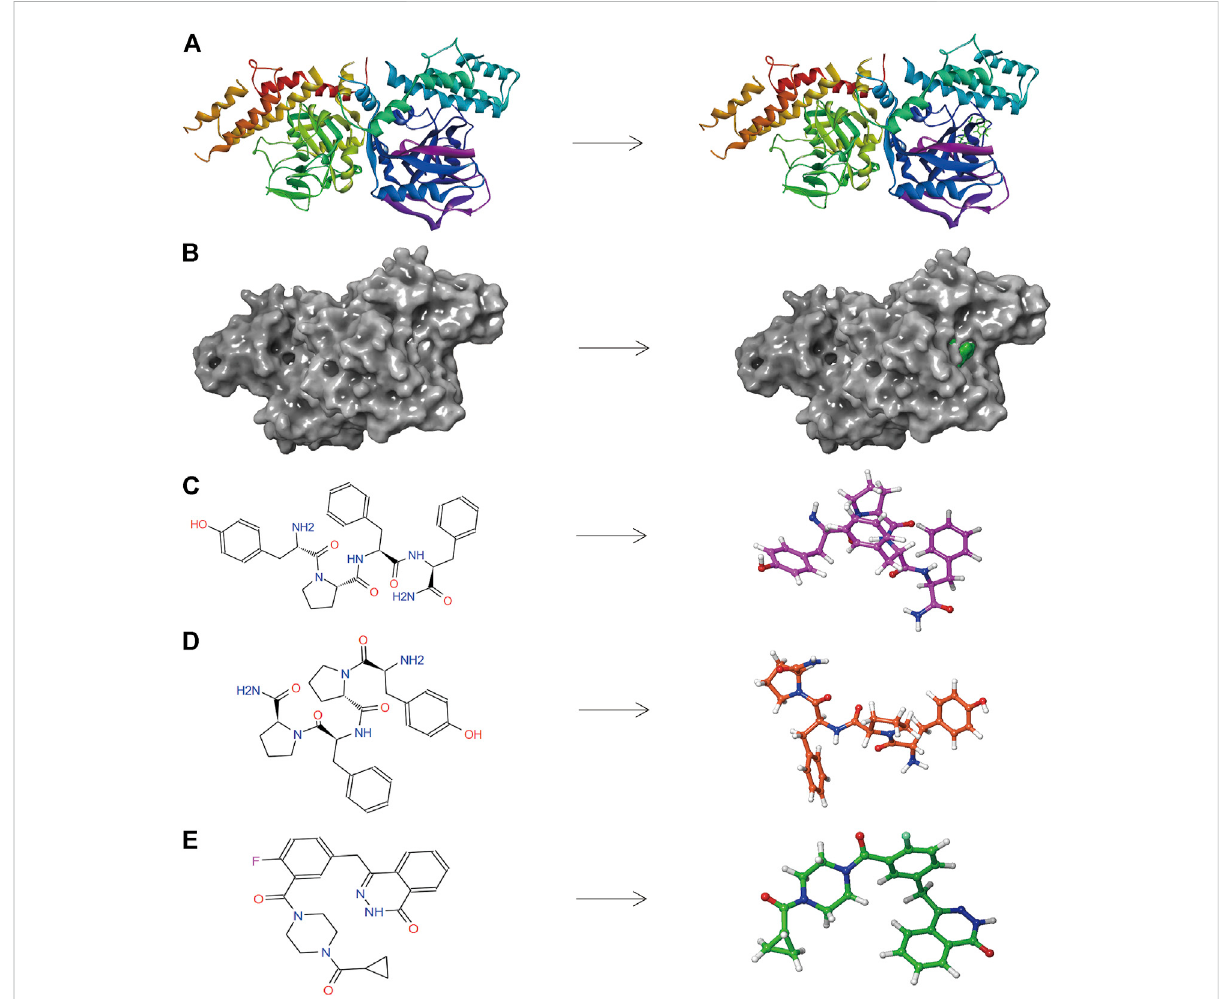
FIGURE 5 (A) The molecular structure of PARP-1 and the complex structure of PARP-1 with Lynparza. Initial molecular structure was shown. (B) The molecular structure of PARP-1 and the complex structure of PARP-1 with Lynparza. The surface of the complex was added, green for Lynparza